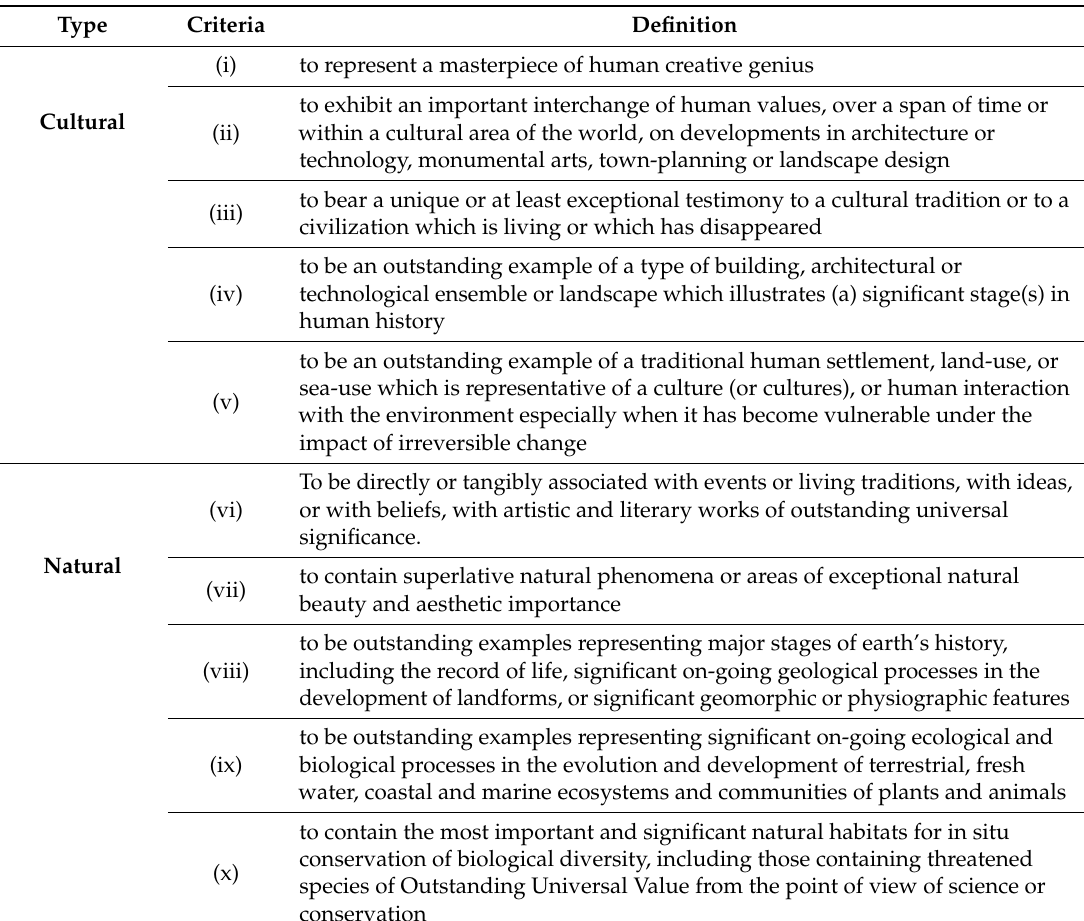
Table 2. The Criteria for Outstanding Universal Value Based on the Operational Guidelines for the Implementation of the World Heritage Convention